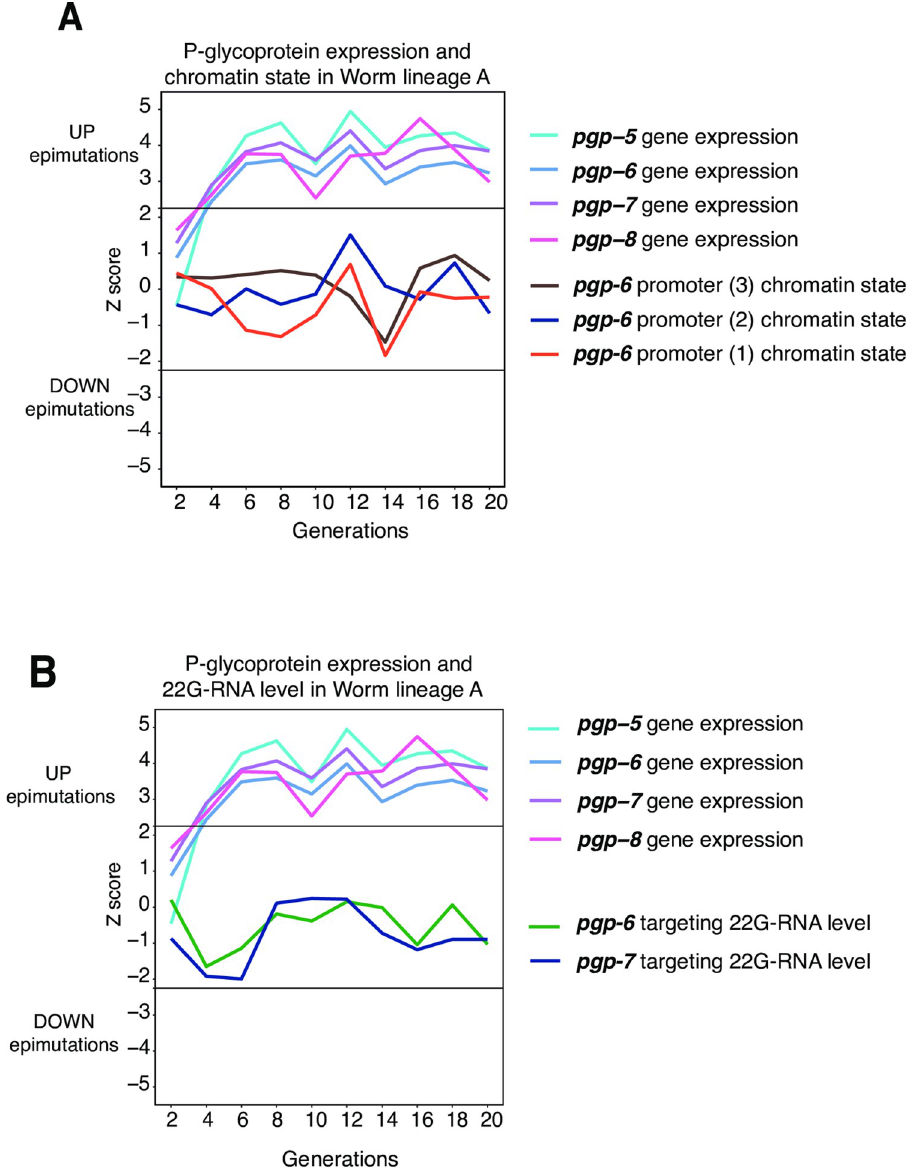
in Lineage A. Generational time points on X-axis. Z-score for epimutation status shown on Y-axis with 0 equivalent to PMA state. Horizontal thresholds indicate Z-score cut-offs; > 2.25 = UP epimutation, < - 2.25 = DOWN epimutation. B. Levels of 22G-RNAs targeting pgp-6 and pgp-7 over 20 generations in Lineage A. Generational time points on X- axis. Z-score for epimutation status shown on Y-axis with 0 equivalent to PMA state. Horizontal thresholds indicate Z- score cut-offs; > 2.25 = UP epimutation, < - 2.25 = DOWN